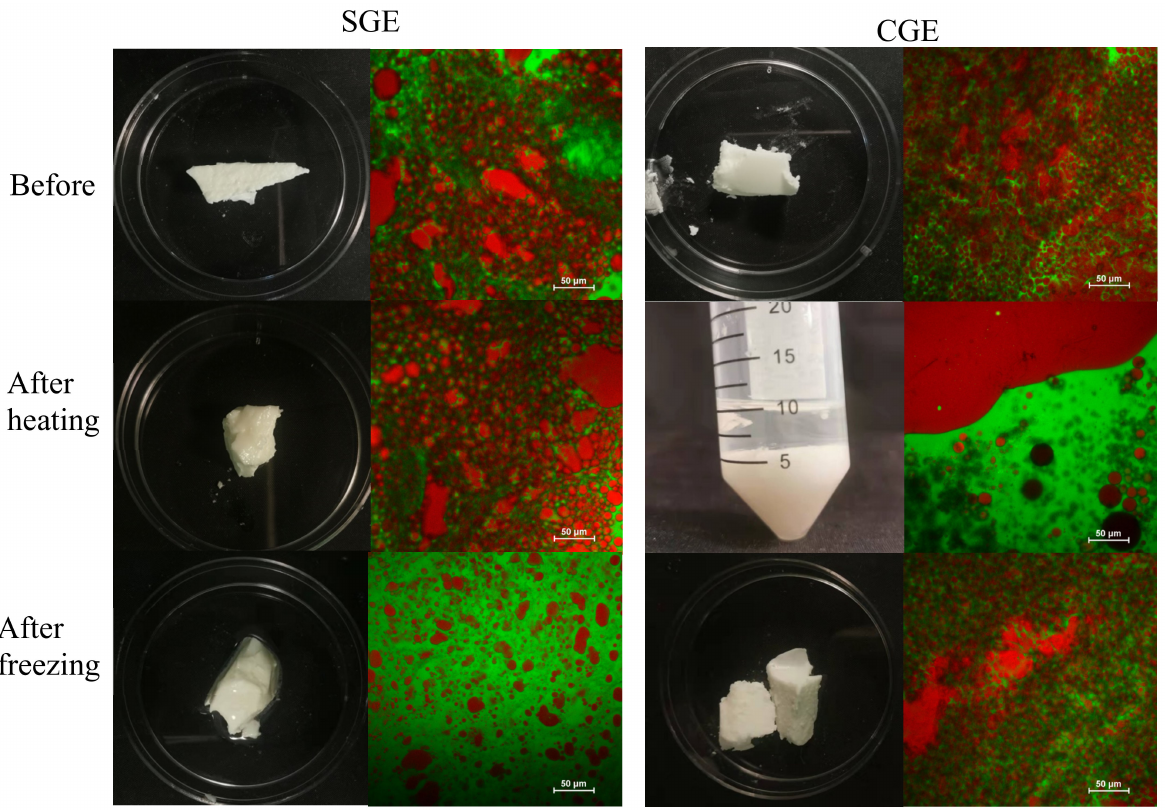
Figure 13. Appearance and confocal microscope images of coconut oil and soybean oil gelled emulsions (GEs) before and after heating and